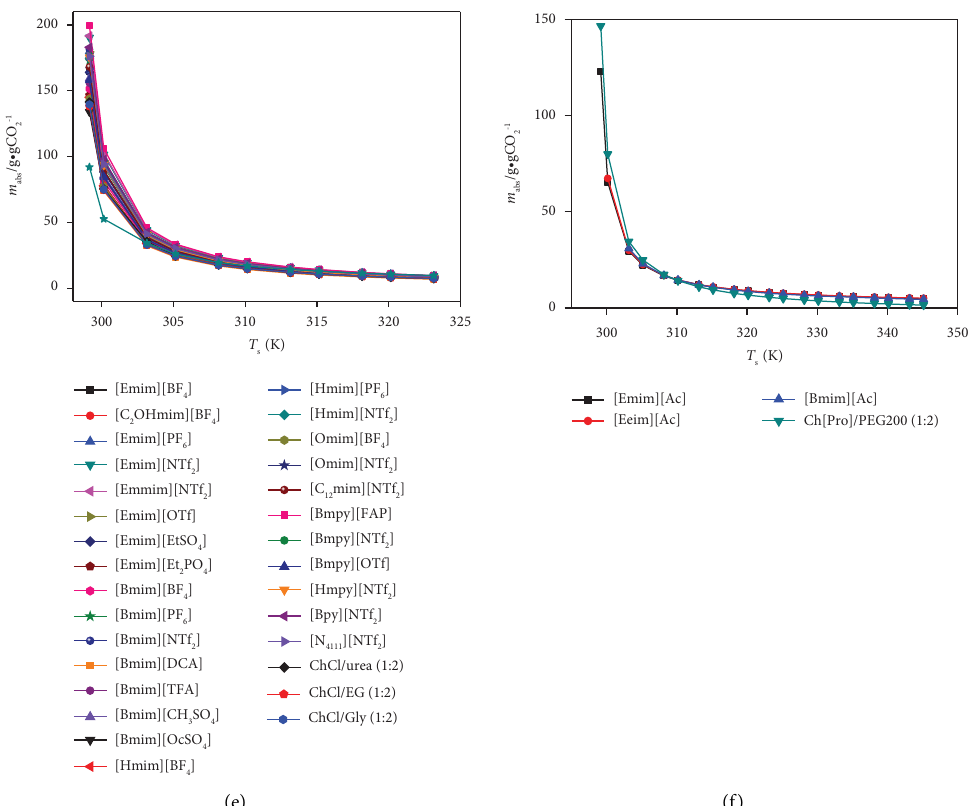
Figure 5: Te absorbent amount of (a) 30 physical absorbents for efuent gases, (b) 4 chemical absorbents for efuent gases, (c) 30 physical absorbents for kiln gas, (d) 4 chemical absorbents for kiln gas, (e) 30 physical absorbents for biomass syngas, and (f) 4 chemical absorbents for biomass syngas.